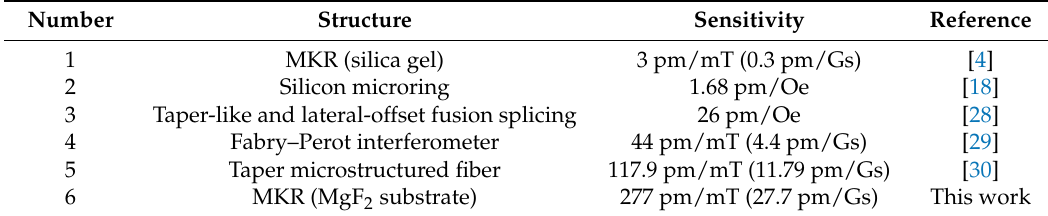
Table 1. Sensitivity comparison of various magnetic field sensing